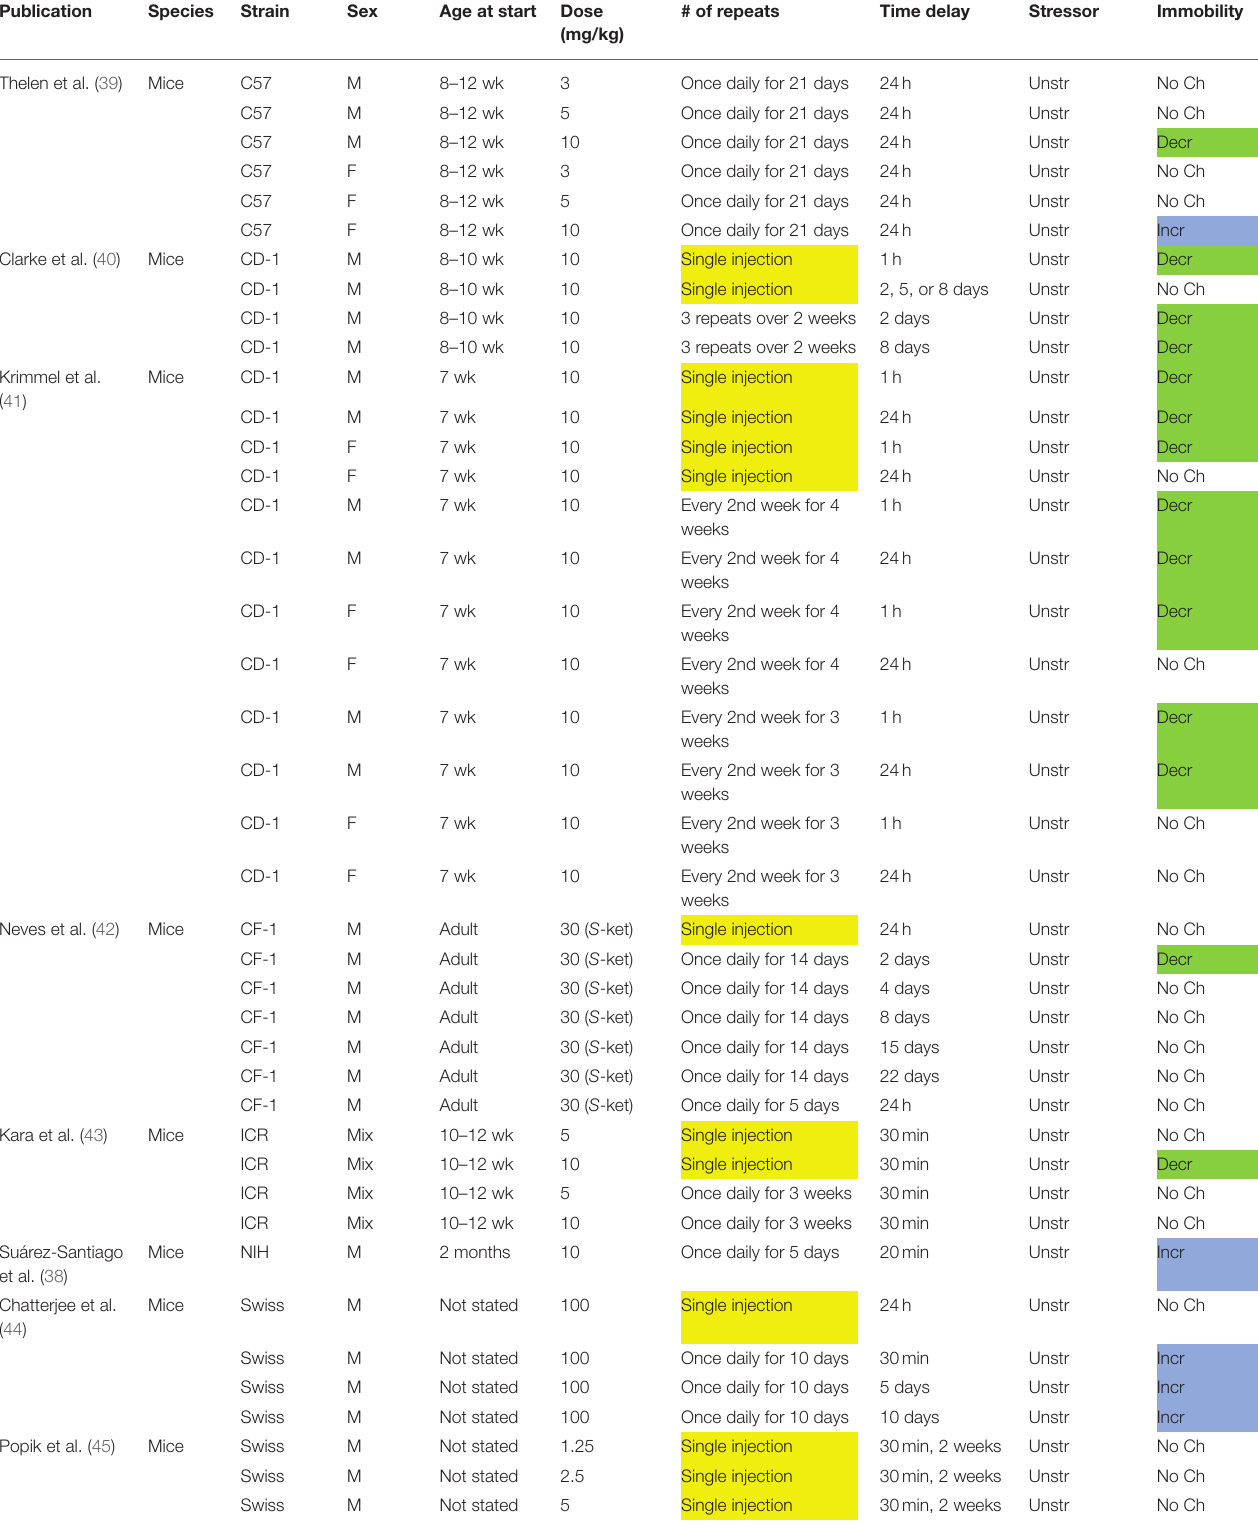
TABLE 1 | Summary of repeated dosing of ( R,S )-ketamine in the rodent forced swim test